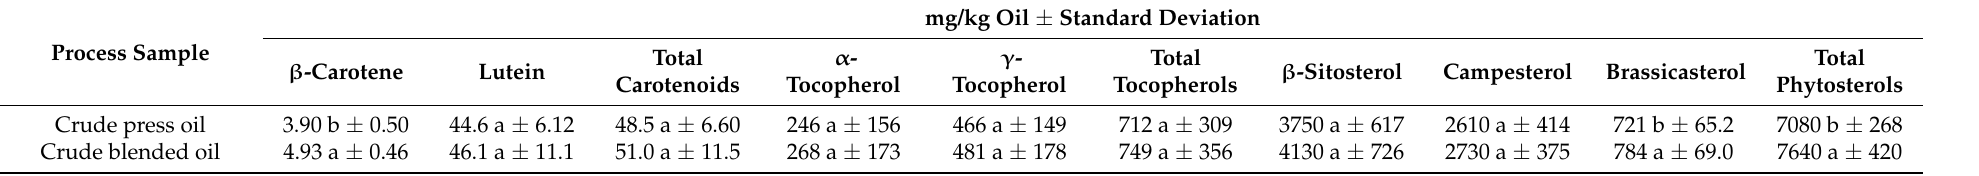
Table 2. Average bioactive concentrations in crude oil samples obtained from process